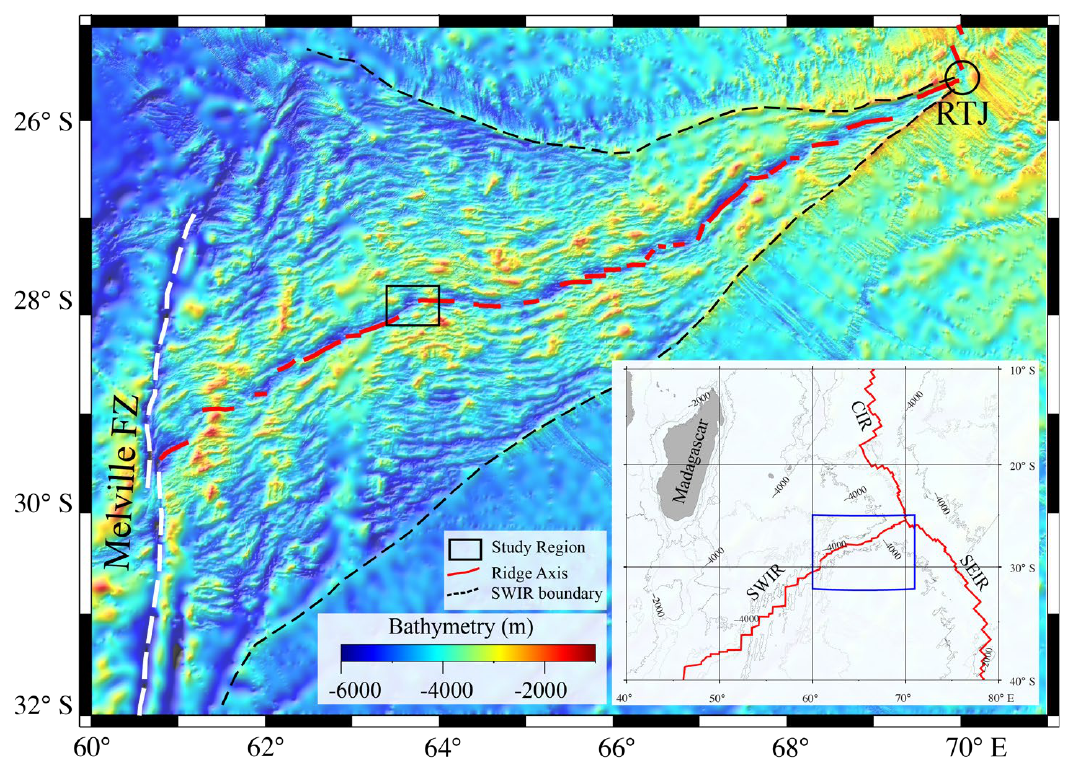
Figure 1. Colour − coded GEBCO bathymetric map of the SWIR between the Melville FZ and Rodriguez Triple Junction (RTJ). The white dashed line represents the Melville Fracture Zone. The SWIR seafloor boundary is marked with black dashes. CIR: Central Indian Ridge; SWIR: Southwest Indian Ridge; SEIR: Southeast Indian Ridge.